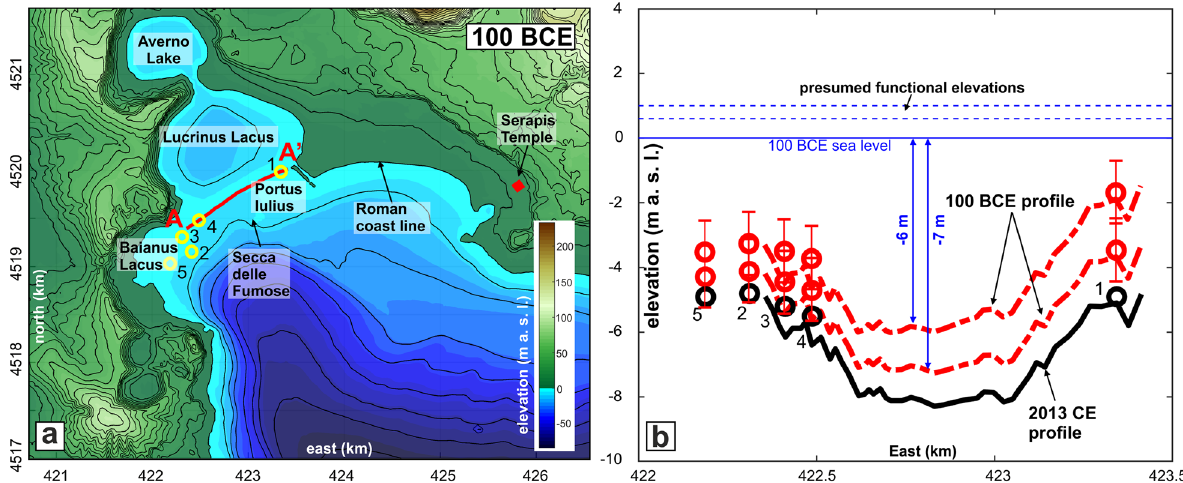
Fig. 6 a Topographic reconstruction following the dome (bradyseism) restoration at 100 BCE alone ( z max data and A–A’ topographic profile (the trace is shown in Fig. 5a) at 100 BCE; the black circles and curve are the 2013 archaeological sites and A–A’ profile, whereas the red circles and curves are the restored elevations resulting from the maximum and minimum values of z